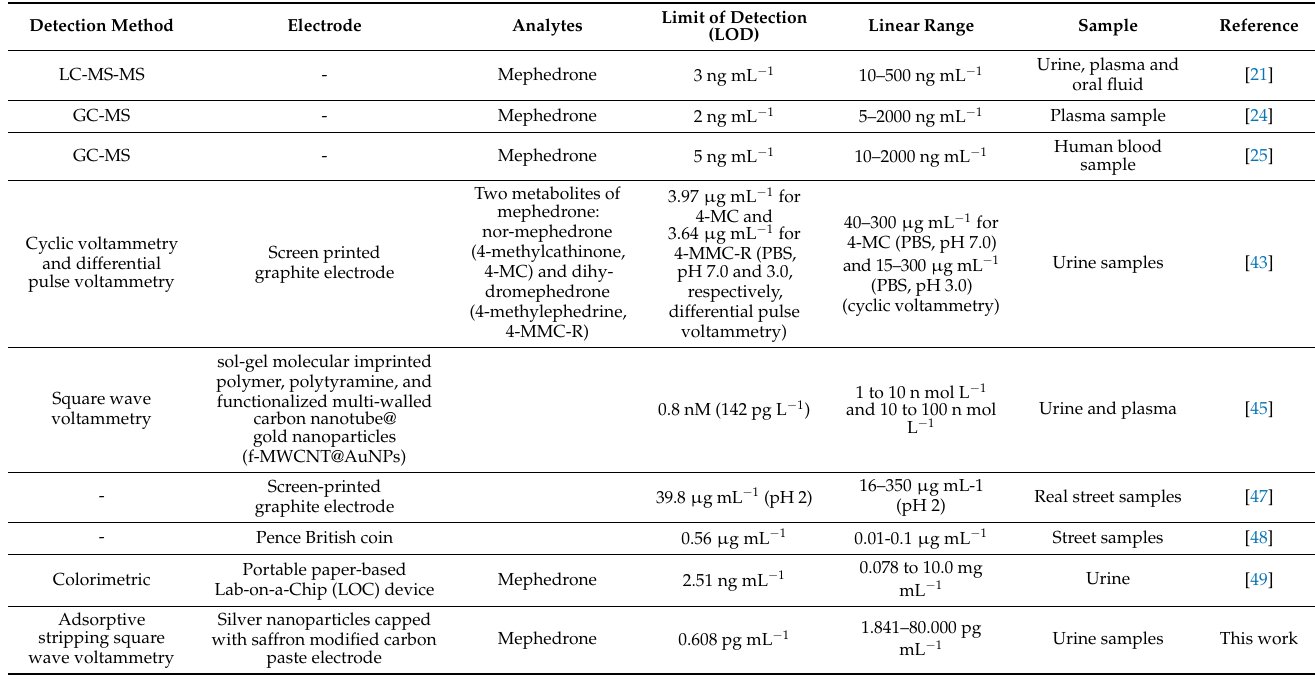
Table 1. Analytical features of selected mephedrone